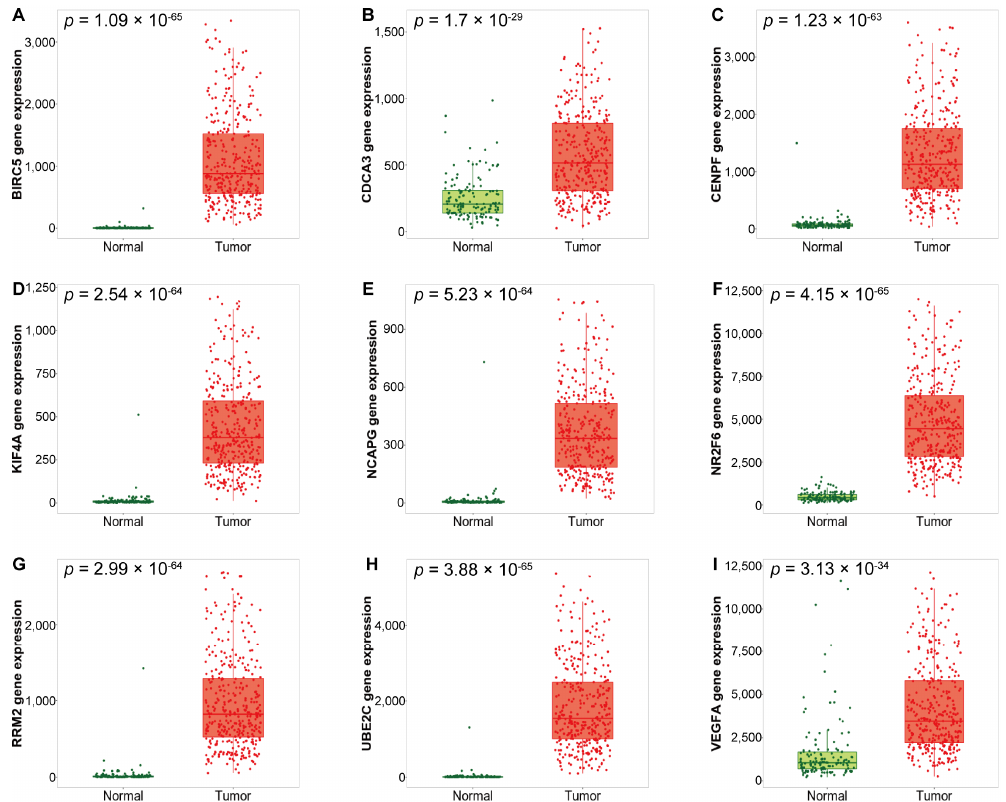
Figure 3. Box plots of up-regulated DEGs expression between normal and serous ovarian cancer tissues in the RNA-seq dataset of TCGA OV. ( A ) BIRC5 , ( B ) CDCA3 , ( C ) CENPF , ( D ) KIF4A , ( E ) NCAPG , ( F ) NR2F6 , ( G ) RRM2 , ( H ) UBE2C , and ( I ) VEGFA mRNA expression. Table 4. Up-regulated DEGs in serous ovarian cancer of the RNA-seq dataset of TCGA OV. Gene Names Gene